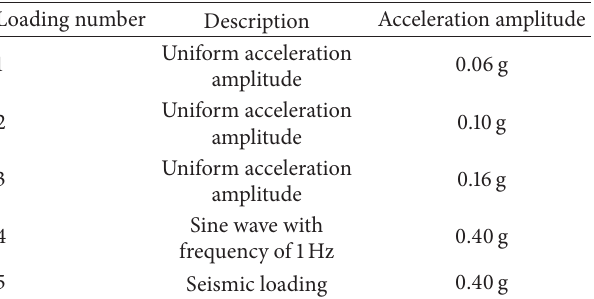
Table 3: Description of loading